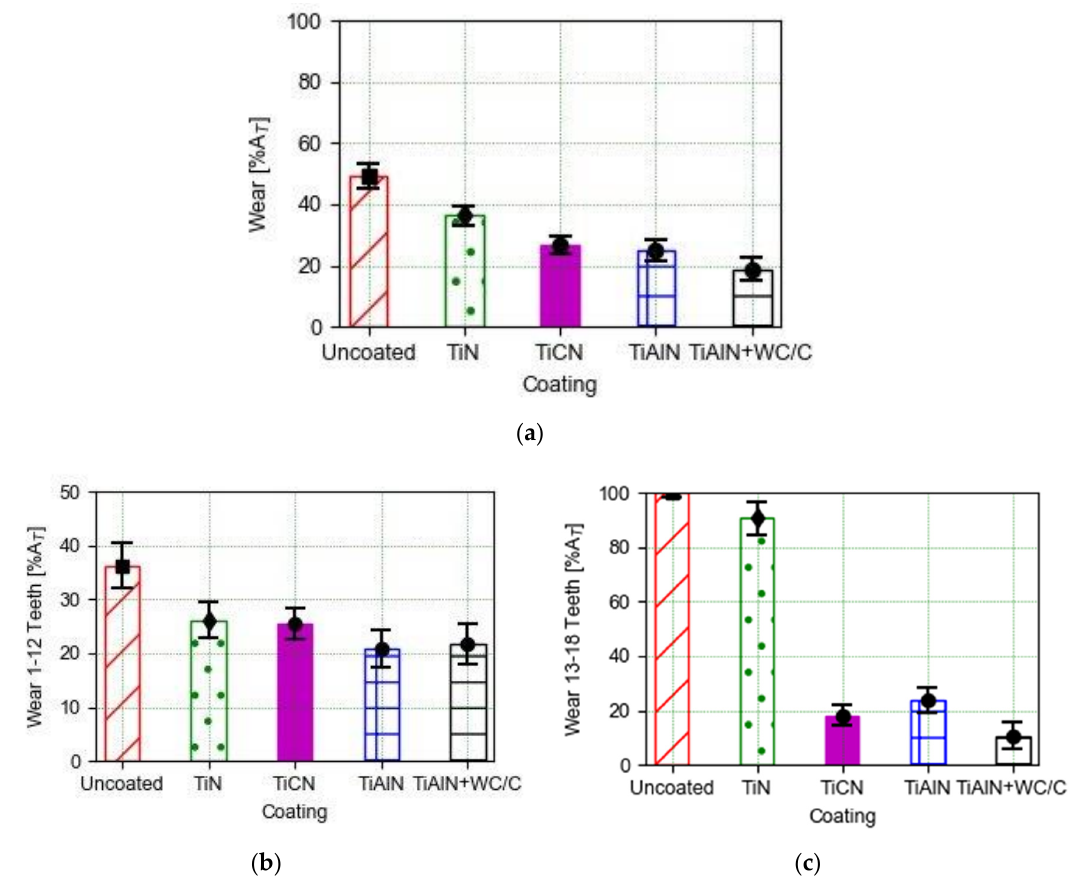
Figure 13. Average evolution of %A in the whole number of teeth ( a ) and separately the conical and conical-cylindrical teeth and ( b ) cylindrical teeth of the different coating taps ( c ).